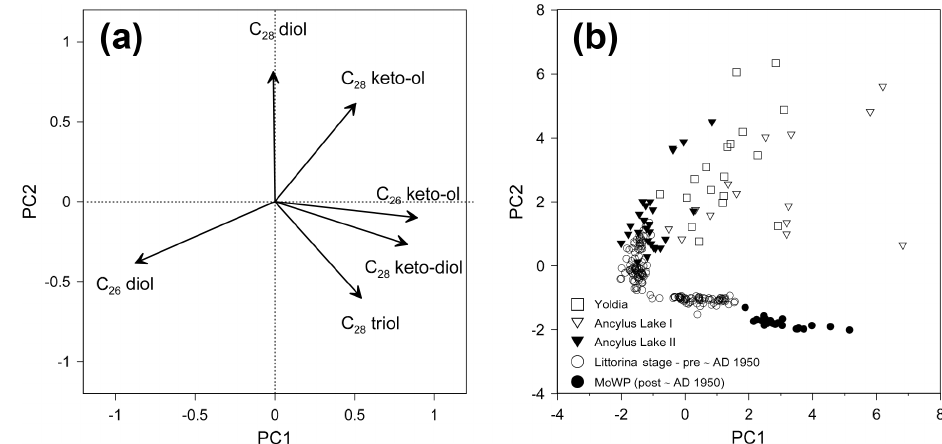
Figure 5. Principal component analysis of the heterocyst glycolipid (HG) distribution in the sediments recovered by the MUC P435-1-4 and the GC 303600 cores from the Gotland Basin, Baltic Sea. (a) The loadings of the six HGs on the first two principal components (PCs), with PC1 accounting for the 47% and PC2 for 29% of the variance. (b) Scores of the sediments from various stages on PC1 and